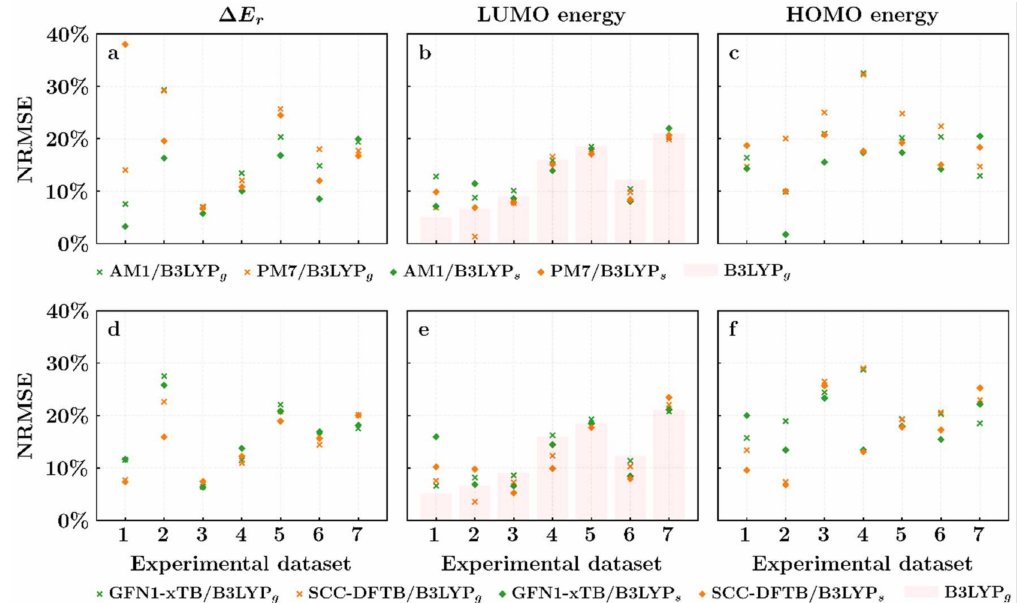
Figure 3. NRMSE of three descriptors: ∆ E r , LUMO energy, and HOMO energy. The hybrid schemes of SEQM/DFT ( a – c ) and DFTB/DFT ( d – f ) were used for the seven datasets. Accordingly, AM1/B3LYP g and AM1/B3LYP s suggest that the molecules were optimized only with AM1, and their energies were calculated by using B3LYP functional either without or with solvation effect, respectively. The shaded vertical bars in ( b , e ) show the fully B3LYP g calculated